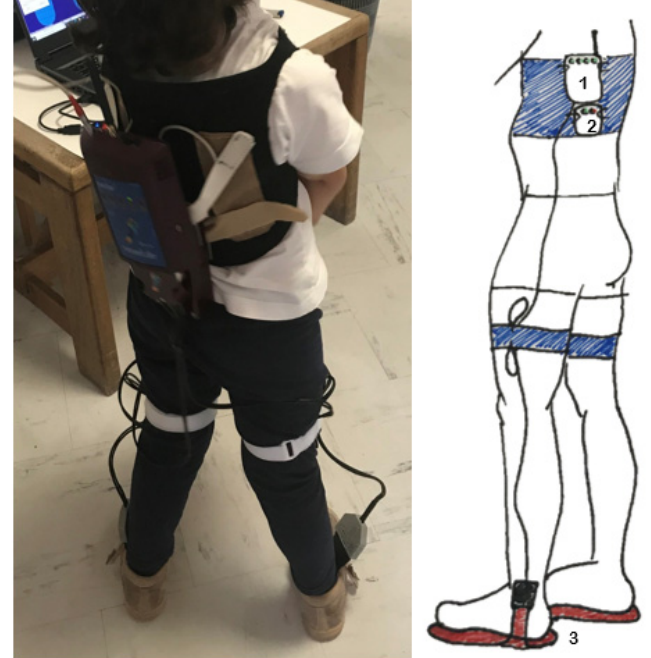
Figure 1. Experimental set up (1—wireless transmitter; 2—batteries; 3—plantar pressure insoles).